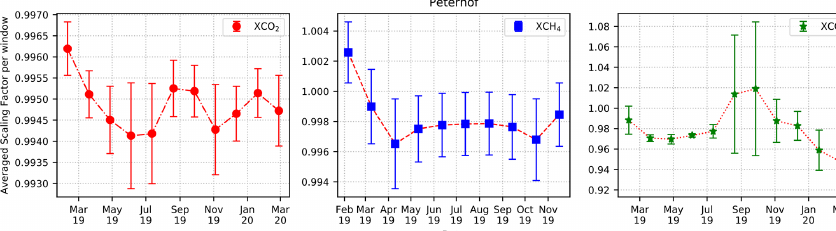
Figure A7. Temporal variation of the averaged scaling factors per window for each studied gas: XCO 2 , XCH 4 and XCO at Peterhof.